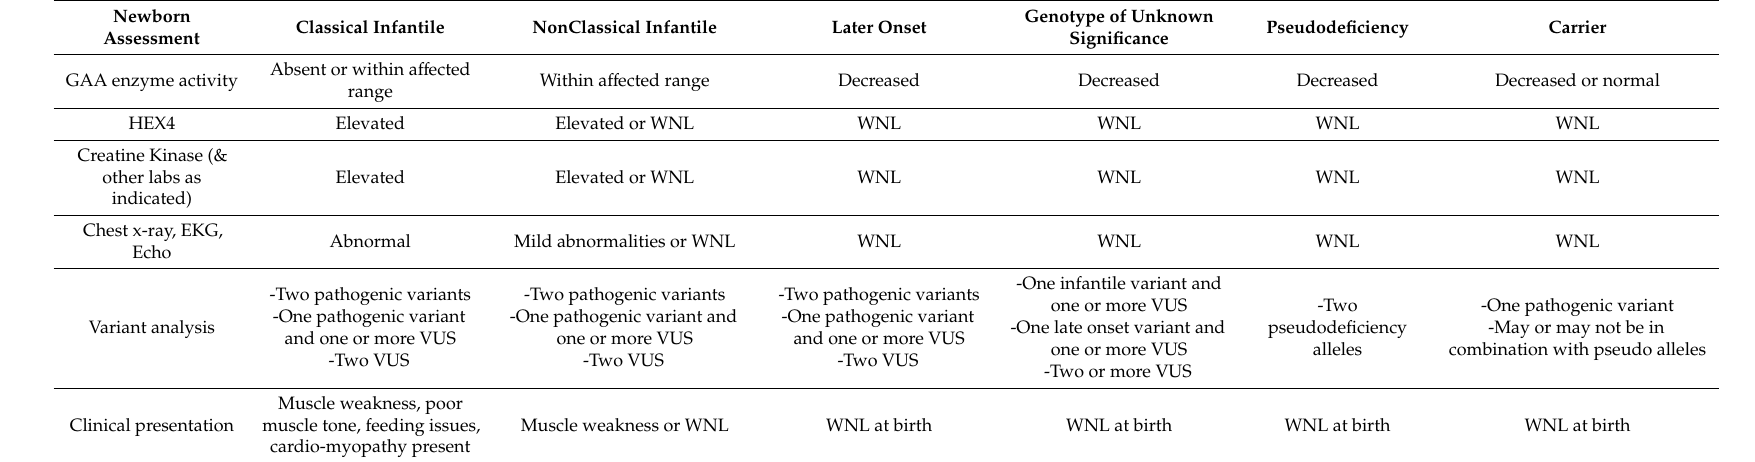
Table 1. Missouri Newborn Screening Follow-Up Criteria for Pompe